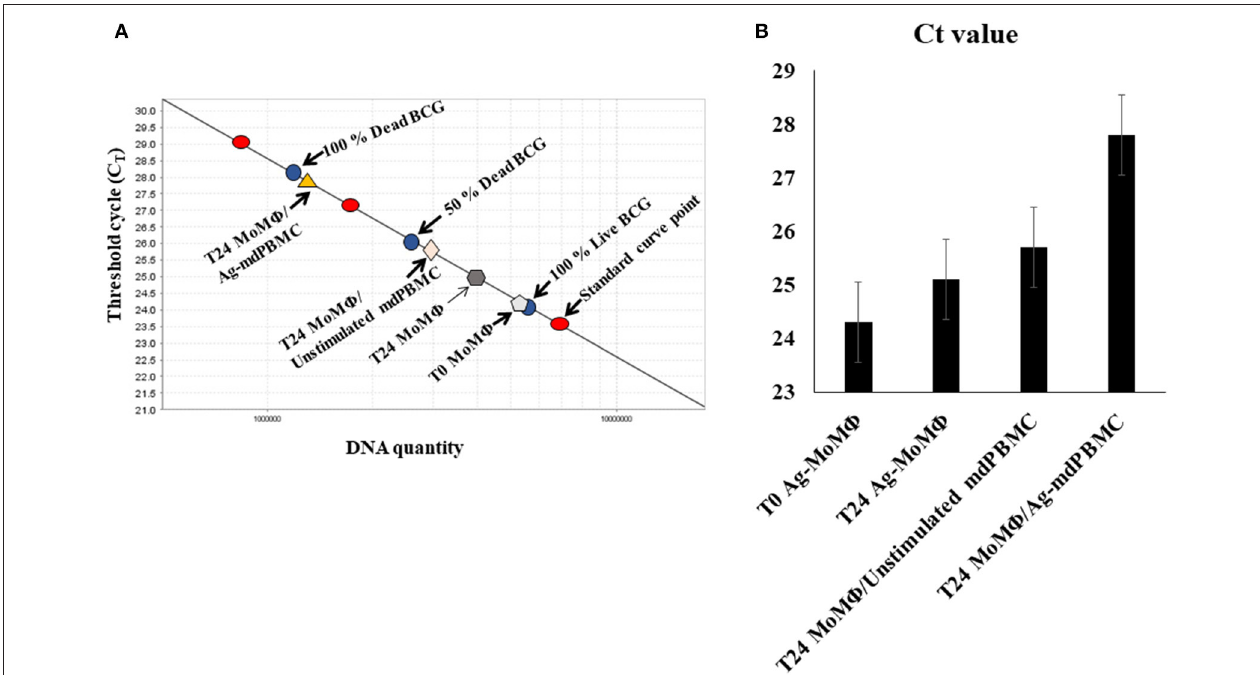
FIGURE 4 | Illustration of the quantitative PCR method using propidium monoazide (PMA) and a single copy gene from Map , F57, or lpqT (Rv1016c) from Mbv BCG to distinguish live from dead bacteria. (A) A standard curve is generated from a single copy gene. A known concentration of DNA from live bacteria (100%), a mixture of 50% live bacteria and 50% dead bacteria, and 100% dead bacteria are used to show the range of sensitivity for quantifying the proportion of intracellular bacteria killed by CD8 CTL. Controls include the percent of live bacteria present in MoM Φ 3h after uptake by MoM Φ , 24h after uptake, and 24h after incubation of MoM Φ with unstimulated mPBMC. Covalent binding of propidium monoazide to DNA is incomplete but sufficient for allowing comparison of the differences in the percent of DNA from live and dead bacteria from infected MoM Φ target cells in relation to the DNA detected in the 100% live, 50% live and 50% dead, 100% dead control ( 13, 23). (B) Histogram illustrating summary results of C t values obtained from standard curve. T0 in (B) refers to infected target MoM Φ pre-incubated with bacteria 3h before use (